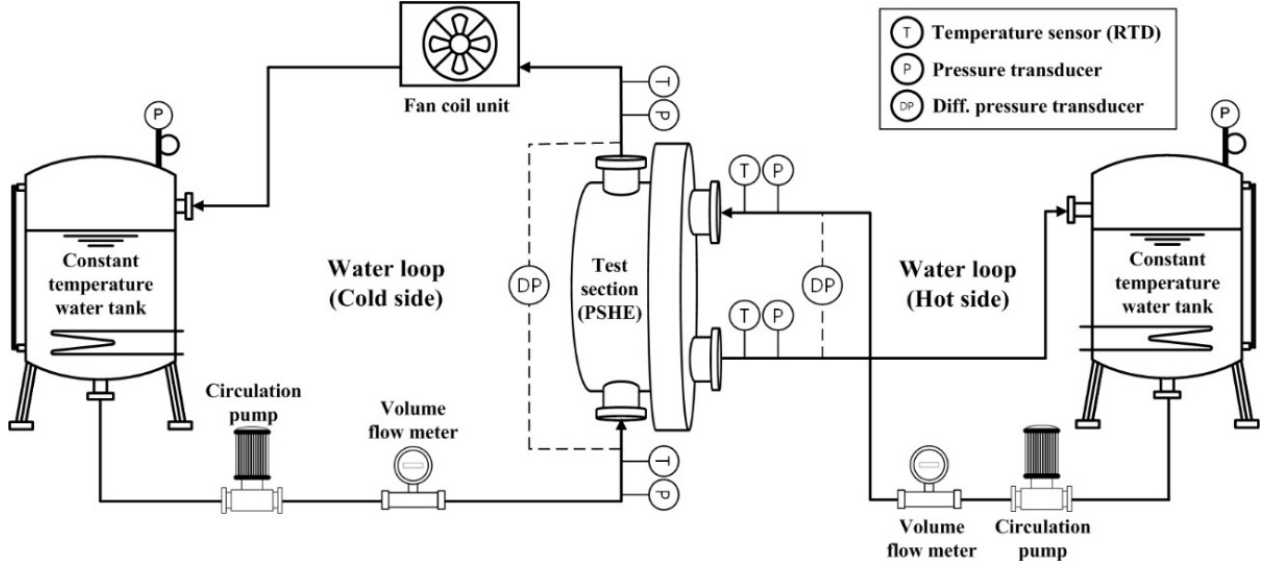
Figure 2. Schematic of the experimental setup.